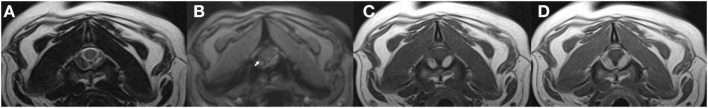
Transverse images at the level of the mid body of C2, in (A) T2, (B) T2*, (C) T1, and (D) T1 + C weighting. The arrow indicates the signal void on the T2* image.